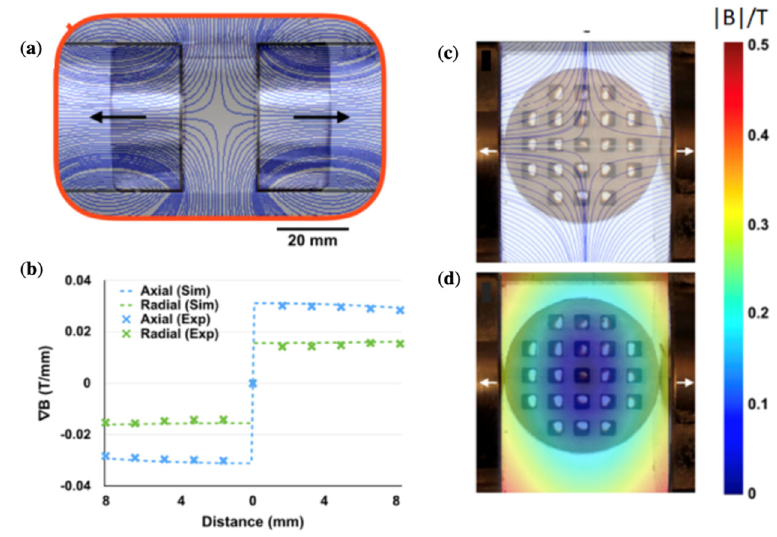
Figure 7. Magnetic field ( a ) and field gradient ( b ) distributions for two NdFeB magnets with opposite polarisation (magnet dimensions: 25 mm in diameter and height, 20 mm between the magnets). The surface field is 0.66 T. The magnetic device contains a sharp zero point surrounded by constant field gradients. ( c , d ) Images of the ferrofluid redistribution in acrylic wells placed between the magnet poles. Reprinted with permission from ref. [34]. Copyright 2020, American Chemical Society.